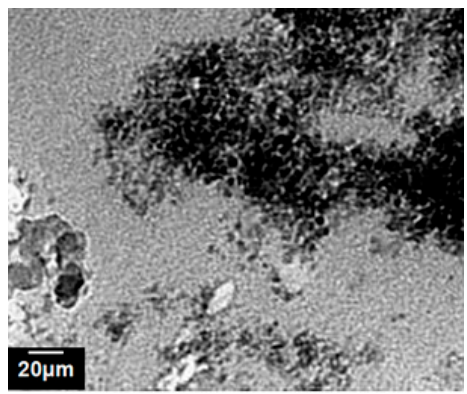
Figure 10. Transmission electron microscopy images of sample P11 morphology.